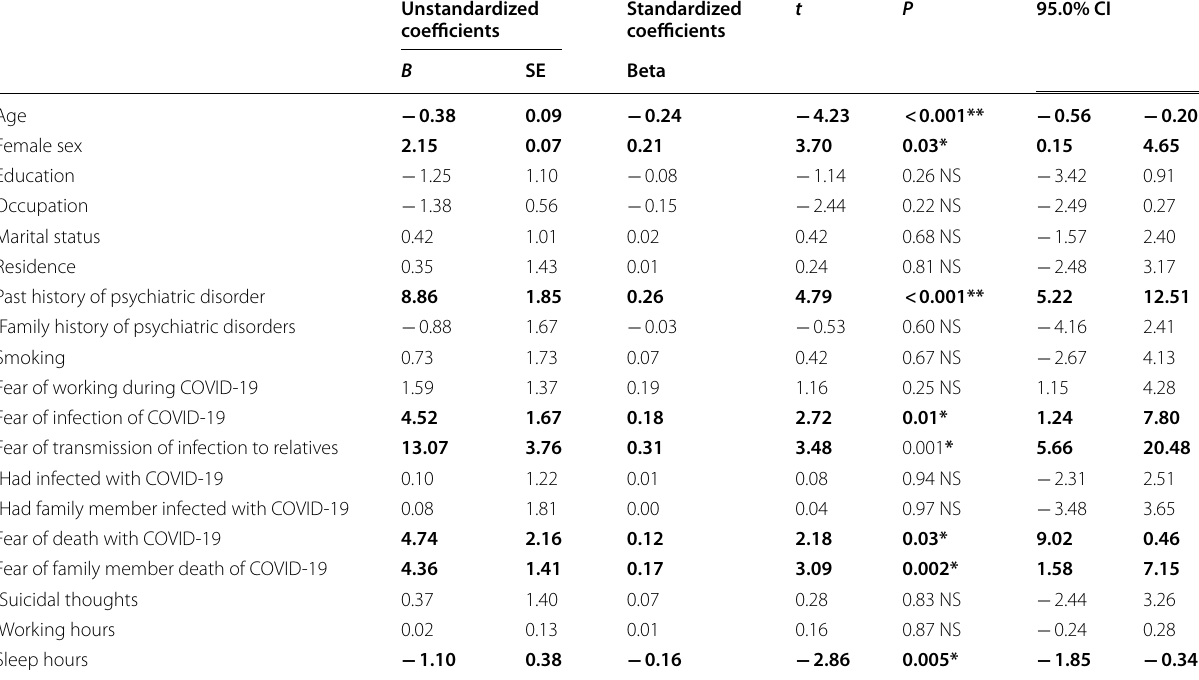
Table 2 Linear regression analysis for predictors for severity of depression according to DASS-21 depression score among the studied